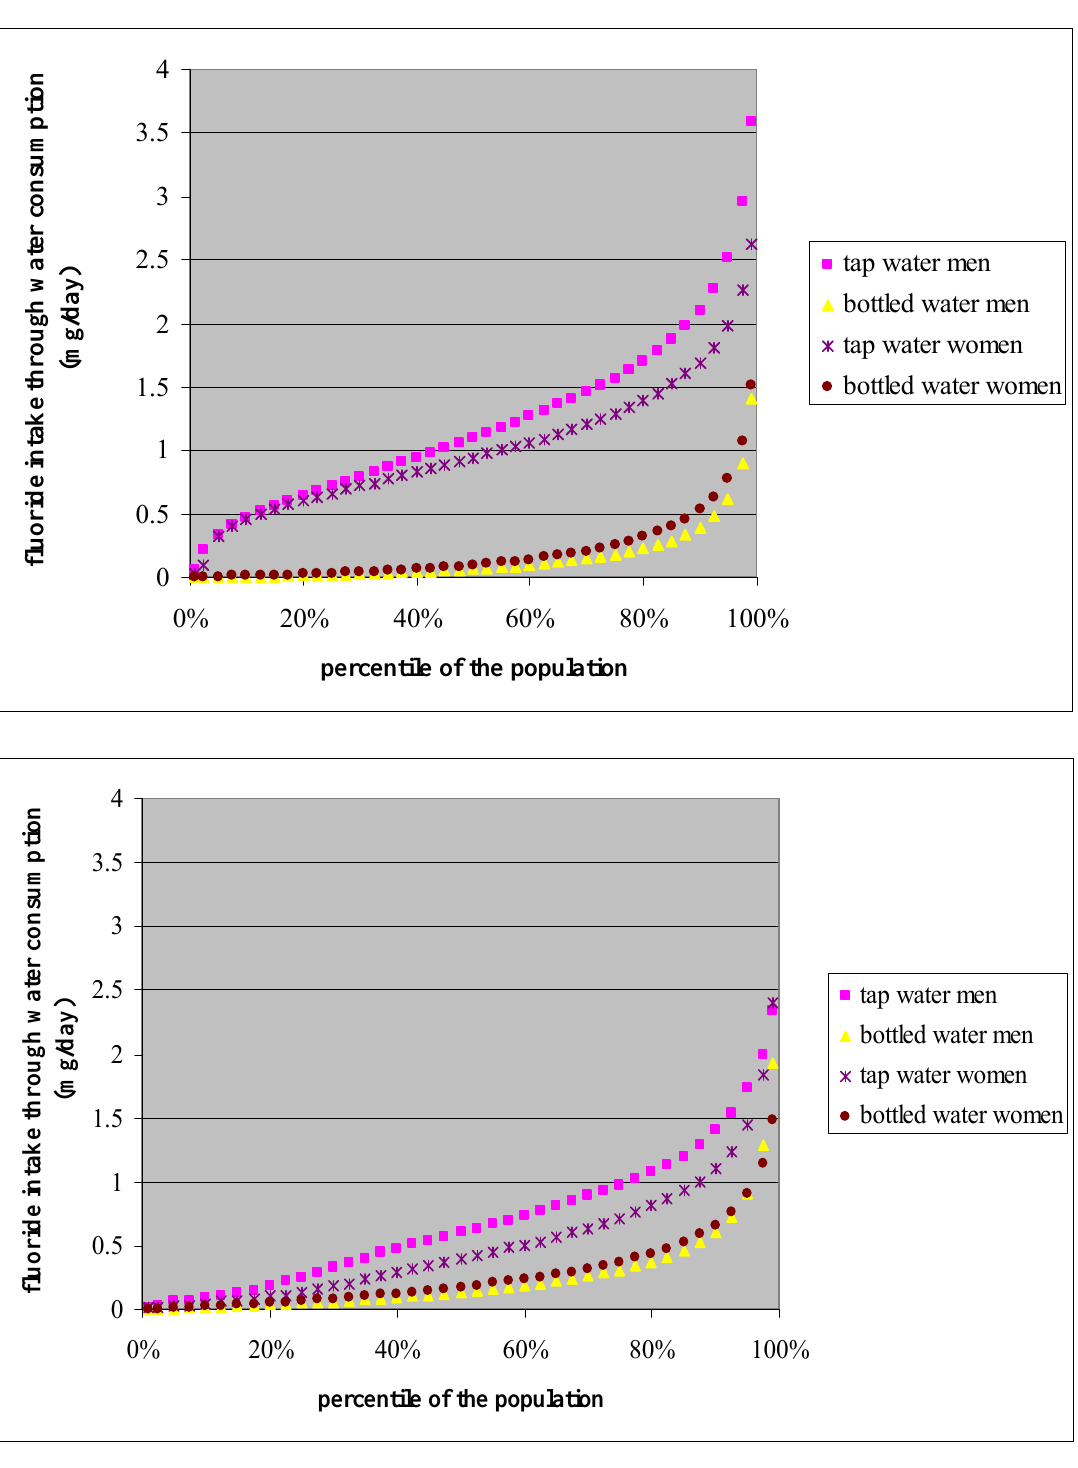
Figure 1. Fluoride intake (mg/day) through consumption of tap water and bottled water by sex, for Flanders (up) and the Walloon region (including Brussels)